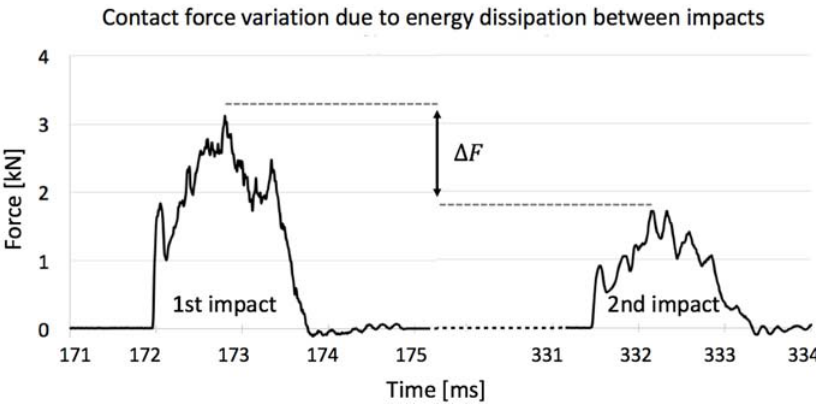
Figure 14. Contact force variation due to energy dissipation between impacts events.